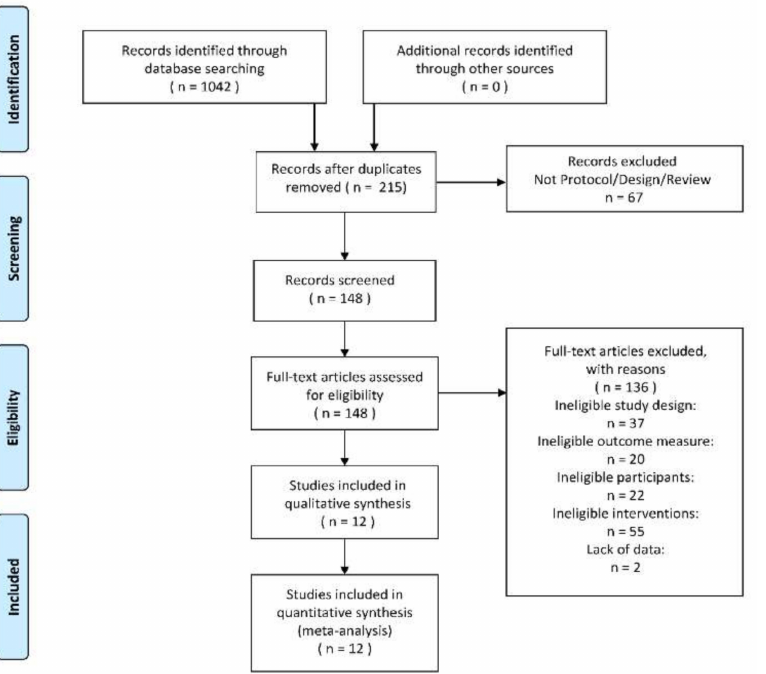
Figure 1. The PRISMA 2009 flow diagram of search and study